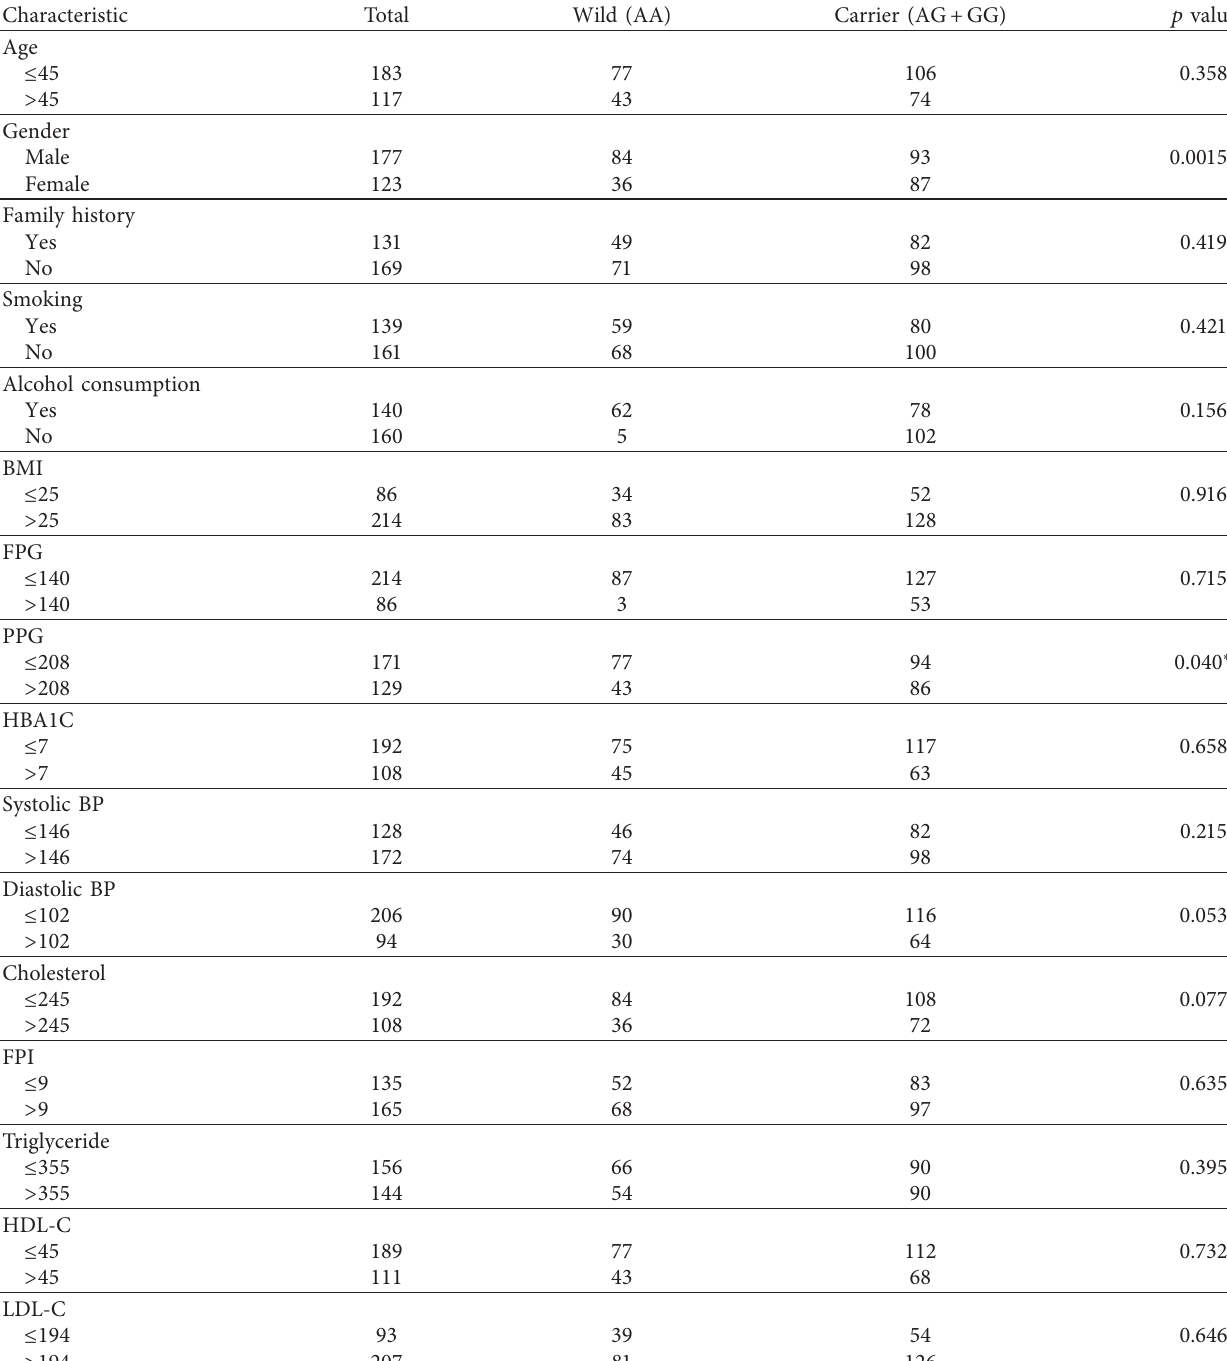
Table 5: Clinicopathological characteristics of T2DM patients between wild and carrier of a variant allele of the KCNJ11 gene.